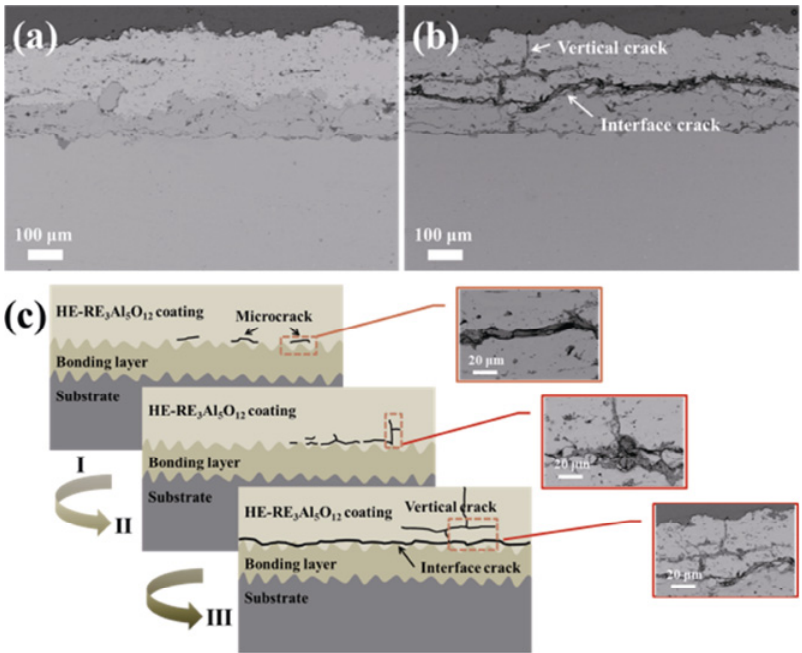
Fig. 10 Cross-section microstructures of HE-RE 3 Al 5 O 12 coatings: (a) at 1200 ℃ after 50 thermal shock cycles; (b) at 1400 ℃ after 10 thermal shock cycles. (c) Indication of the microstructure evolution process of the HE-RE 3 Al 5 O 12 coating ((I) initiation of microcracks, (II) crack propagation, and (III) crack